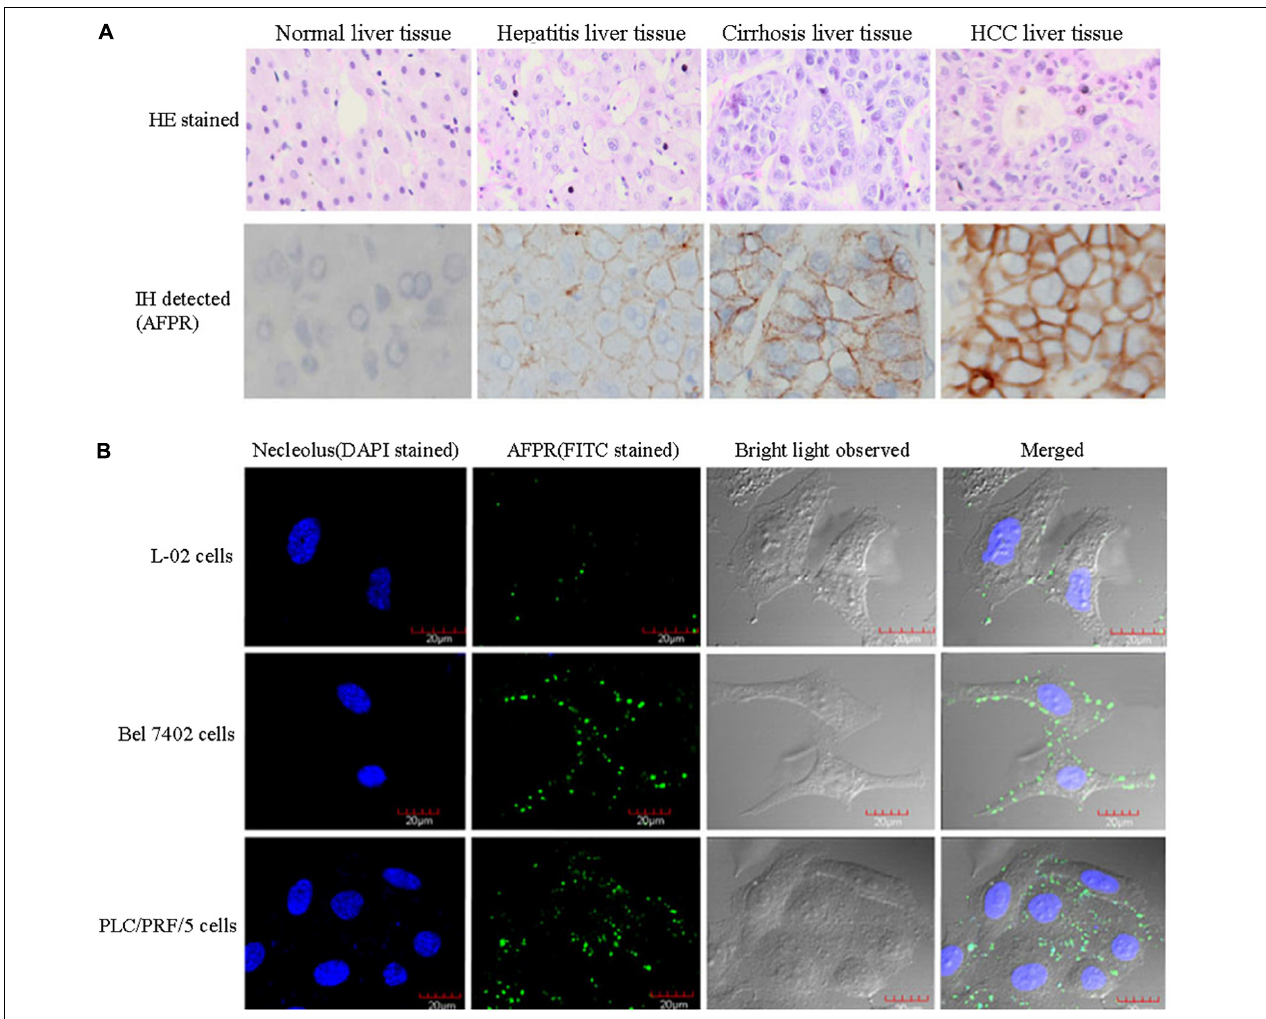
FIGURE 1 | Expression of AFPR in clinical patient liver tissues and HCC cells. (A) Clinical liver tissue samples were collected after surgical hepatectomy, and the expression of AFPR in clinical patient liver tissues was detected by immunohistochemical assays. HE stained: hematoxylin-eosin stained; IH stained: immunohistochemical stained; red arrow indicates AFPR. (B) Expression and localization of AFPR (green fluorescence) in HCC cells were observed by laser confocal microscopy. Reprinted from Li et al. (2013) with permission from